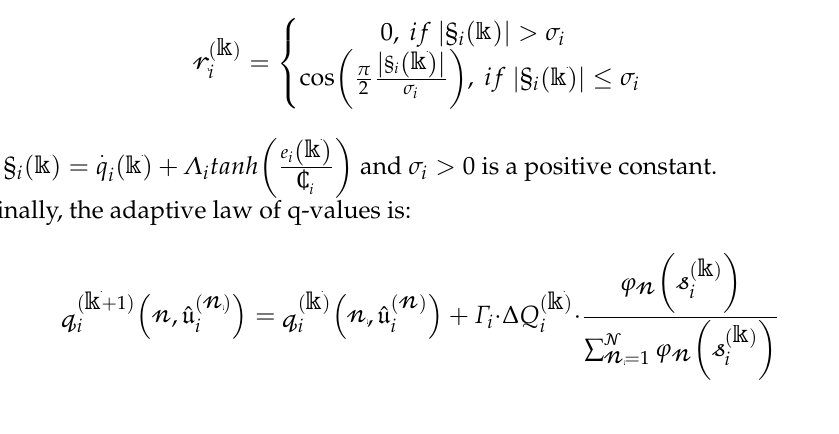
Figure 2. Membership function of fuzzy input of the 𝑖 (cid:3047)(cid:3035) subsystem.